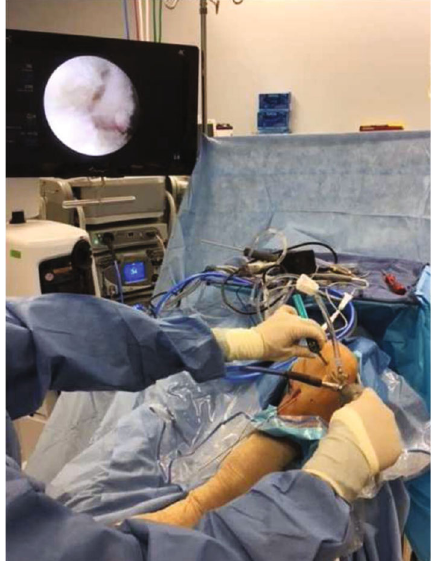
Figure 4: Intraoperative photo demonstrating the positioning of a curved endoscopic femoral drill guide, aimed at approximately 40 ° angle above the horizontal plane.